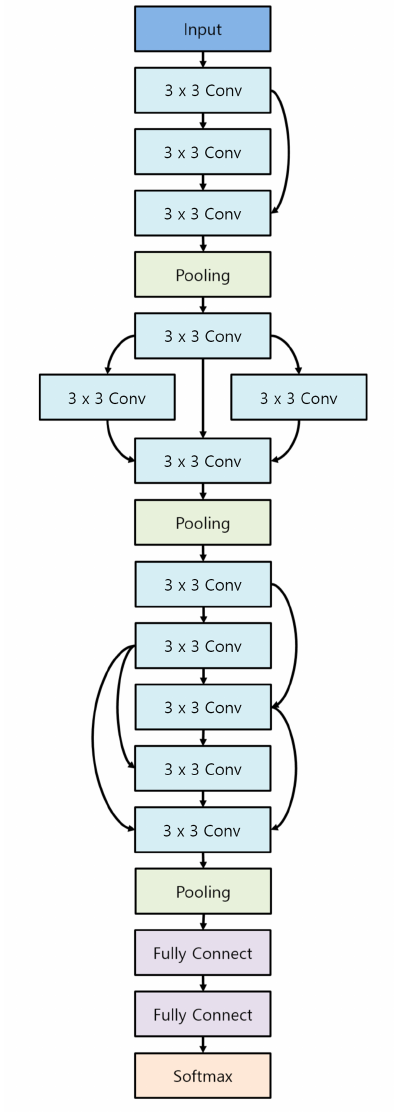
Figure 7. Final network architecture suggested by